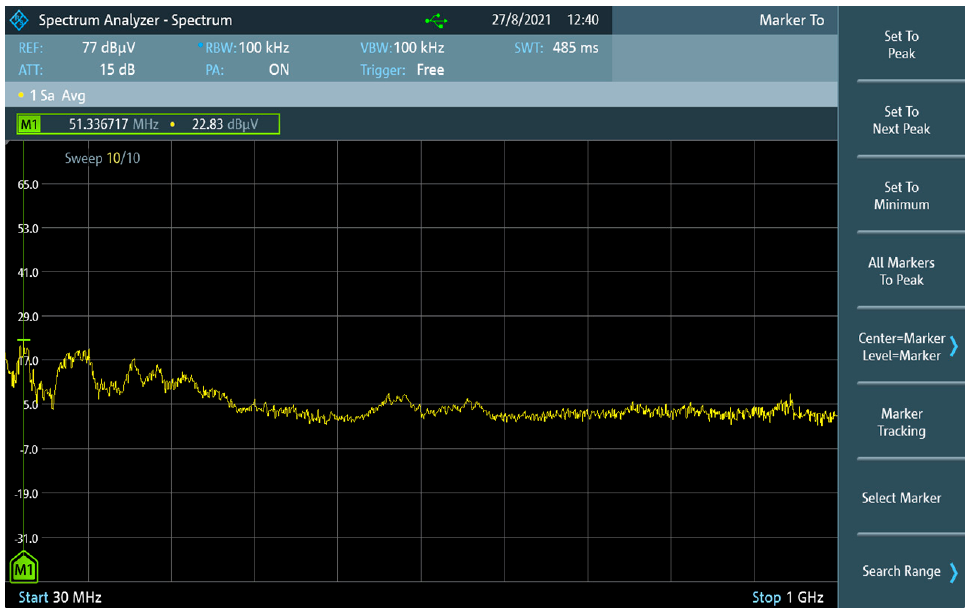
Figure 14. EMI measurement spectrogram of Block B1.